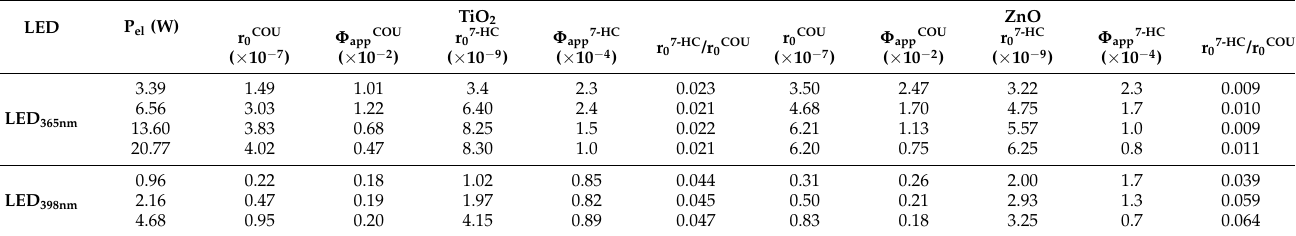
Table 1. The apparent quantum yields ( Φ app ) of the transformation of COU and the formation of